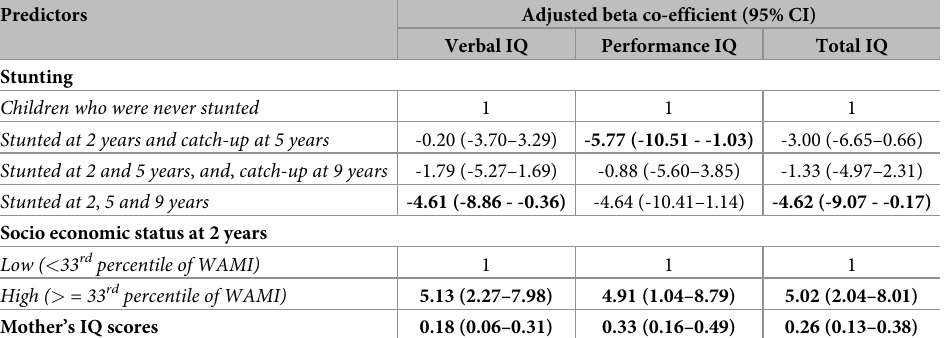
Table 4. Association of stunting status at 2, 5 and 9 years and verbal, performance and total IQ scores at 9 years of age using regression analysis (n = 200 # ). Predictors